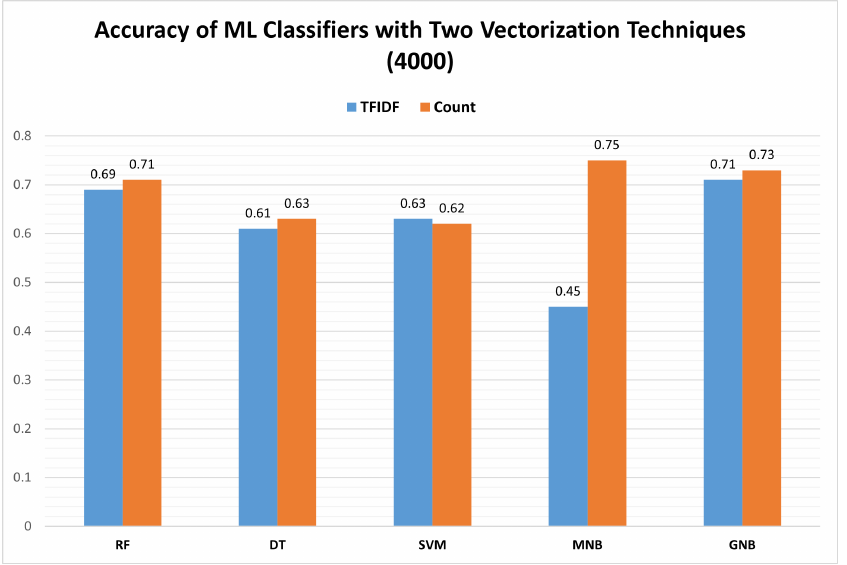
Figure 7. Accuracy of the large data set (4000